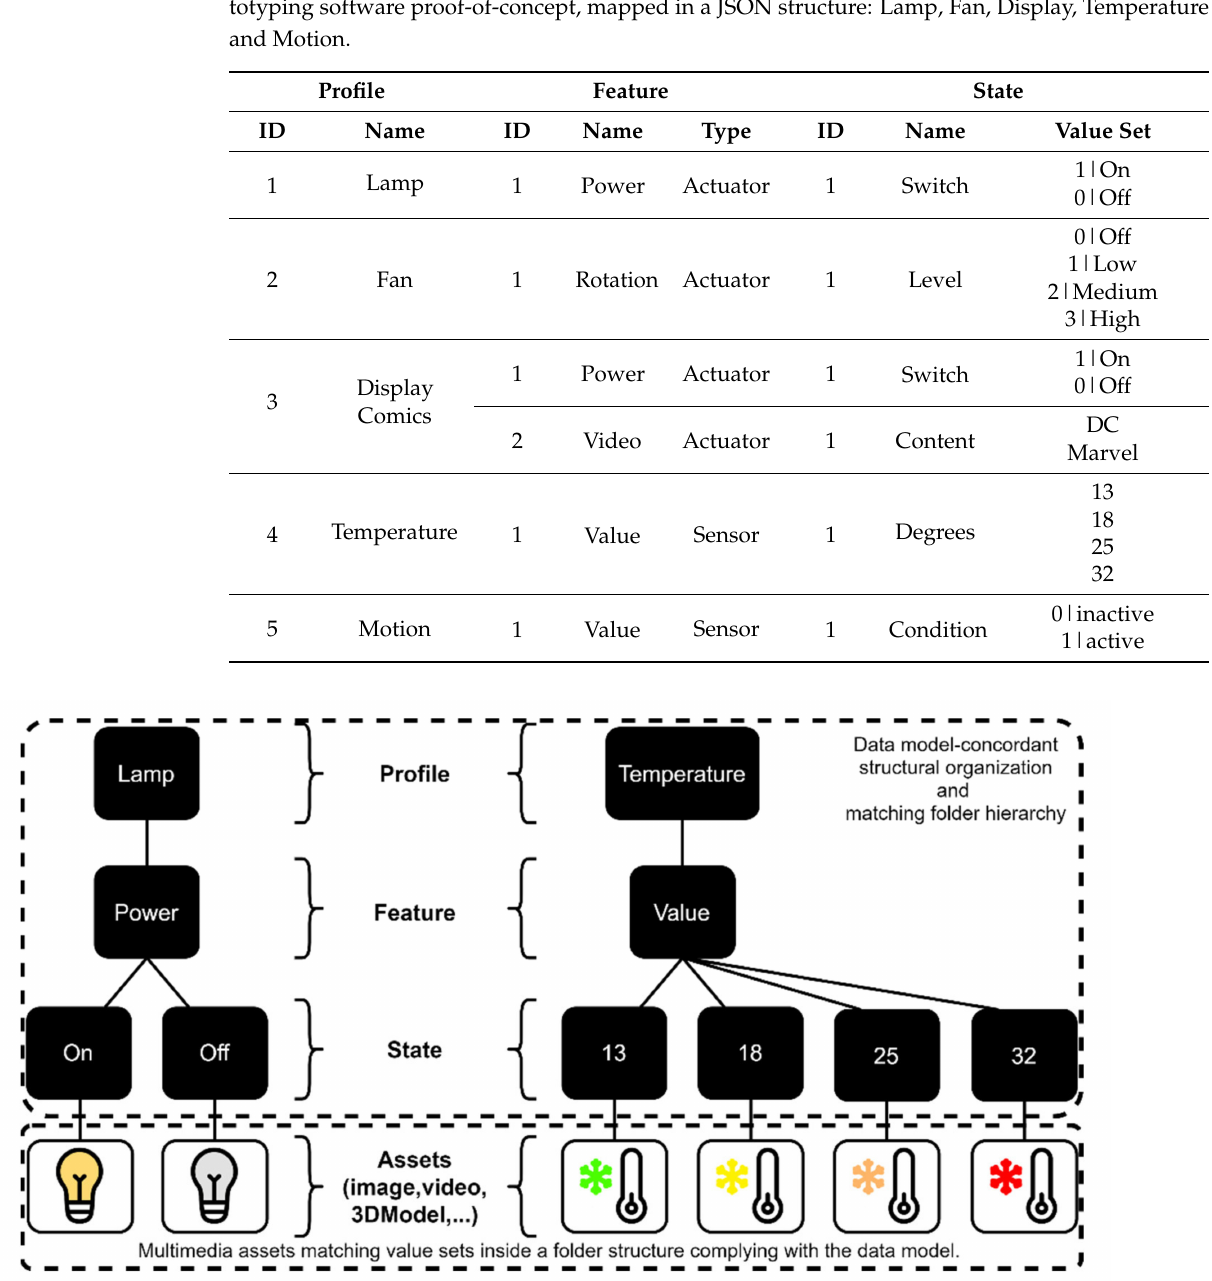
Table 2. Profiles, features, and states considered for the proposed IoT mulsemedia environments pro- totyping software proof-of-concept, mapped in a JSON structure: Lamp, Fan, Display, Temperature